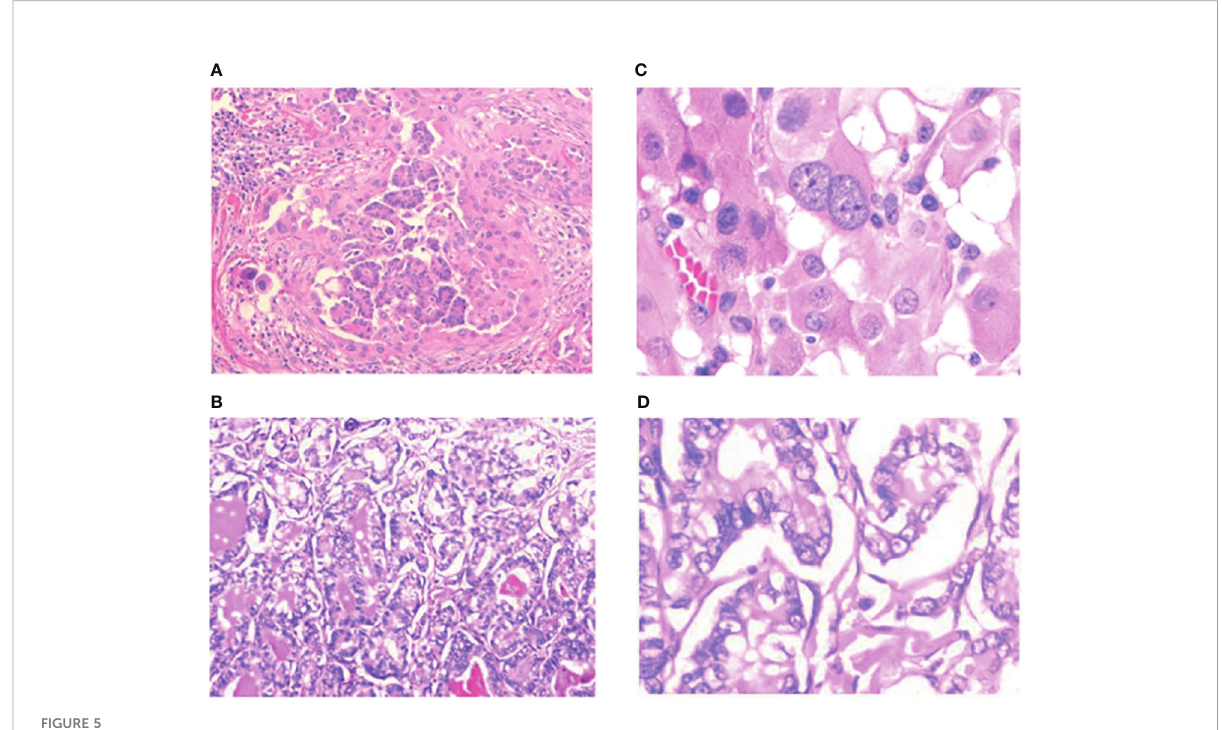
FIGURE 5 Pathological images of PSCTC. (A, B) 100×, (C, D)